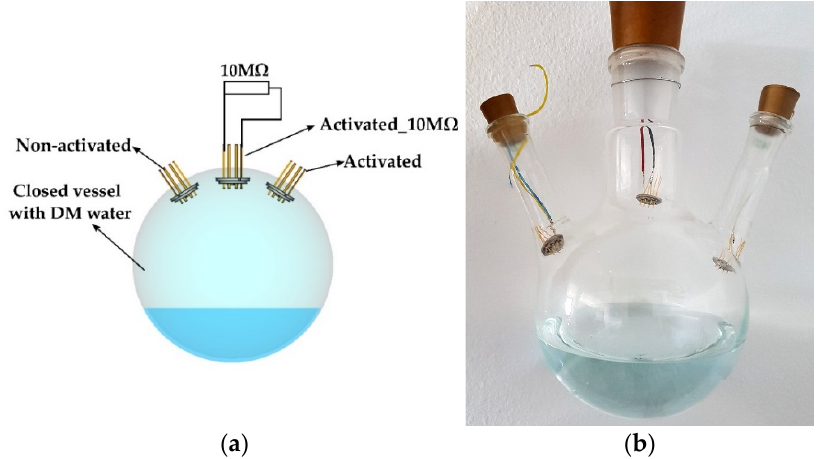
Figure 9. ( a ) A graphical illustration and ( b ) photograph of sensor preparation for µ-FTIR meas- urement.